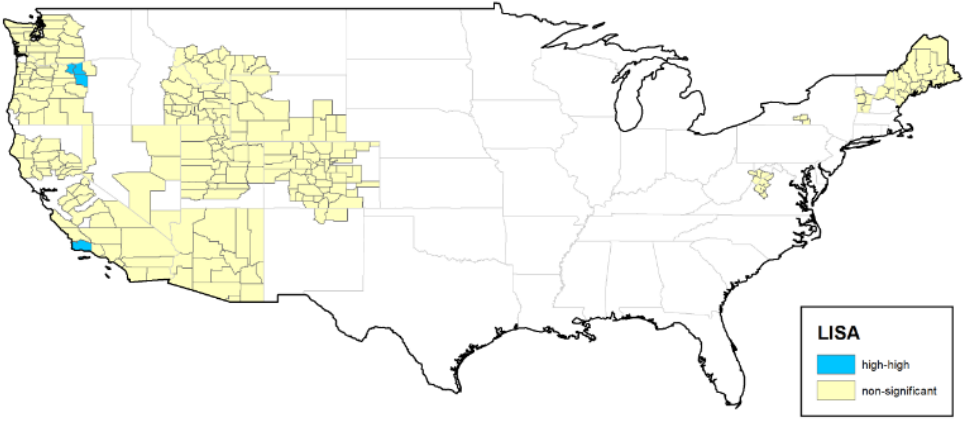
Figure A7. Spatial Autocorrelation of Fires by County. Spatial autocorrelation map for fire size (acres) indicated. Ventura County, CA, and counties in north-central Oregon have large fires and are surrounded by other counties that also have large